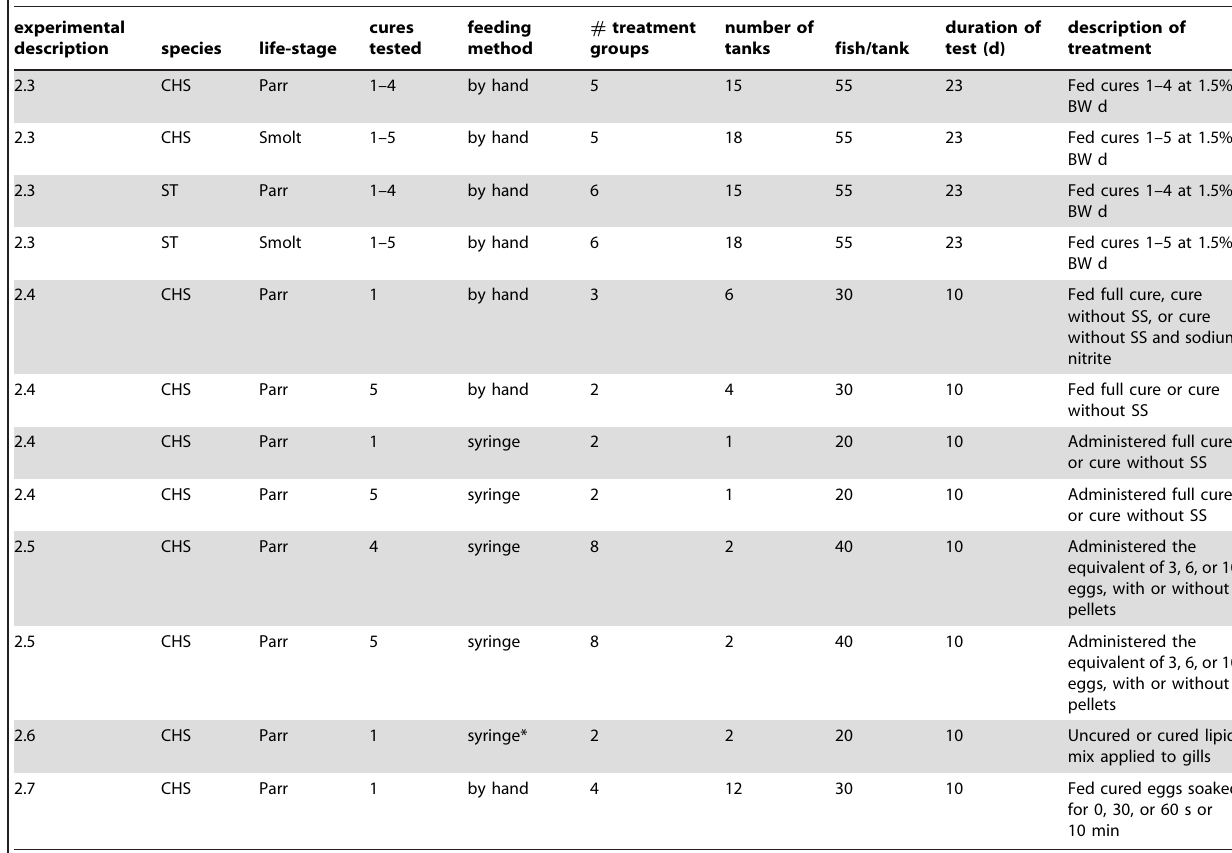
Table 1. Description of experimental